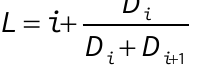
Figure 5. Image fusion results of test